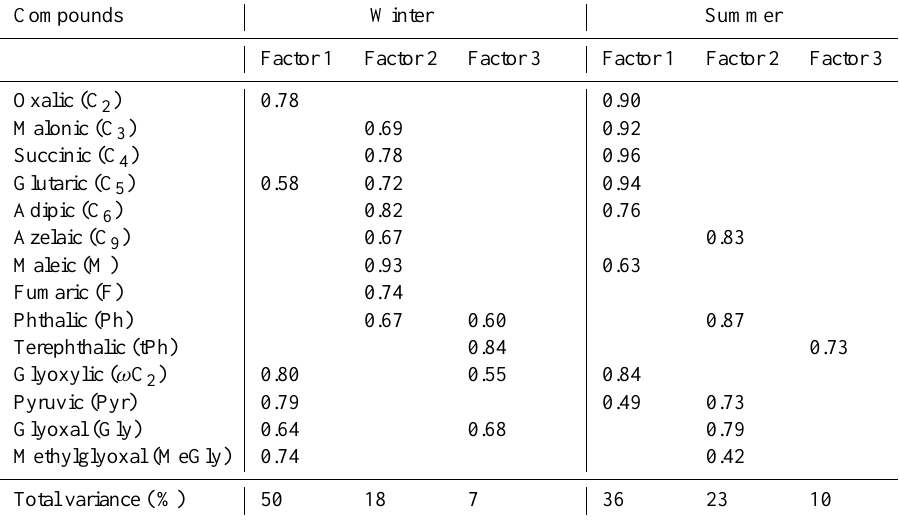
Table 3. Results of principal component analyses on the selected dicarboxylic acids and related compounds in Himalayan aerosols.